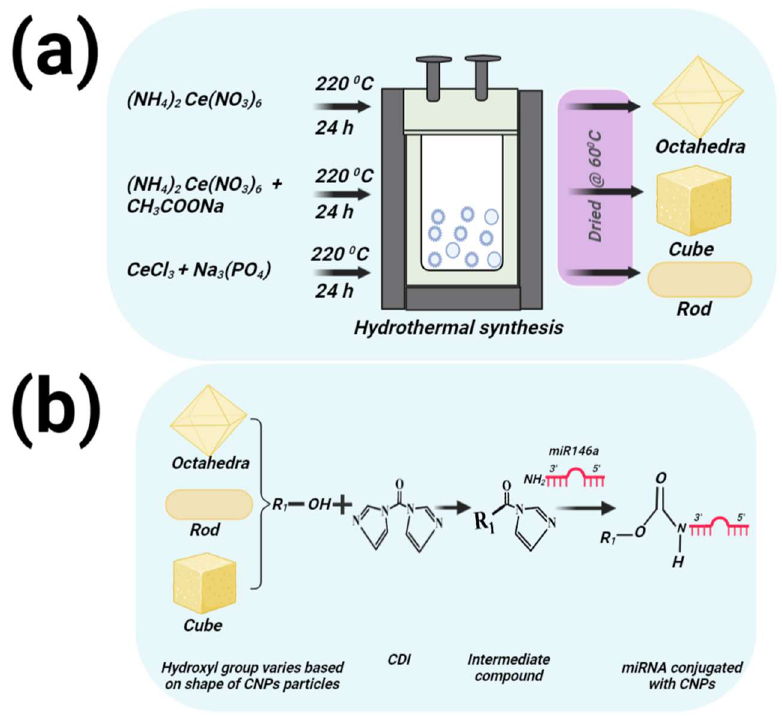
Figure 1. The schematic diagram represents the synthesis ( a ) of CNPs of unique morphologies and conjugation of miR ( b ) with CNPs of each formulation. CN Oct , CN C , and CN R were synthesized under different reaction times and temperatures using a hydrothermal method.